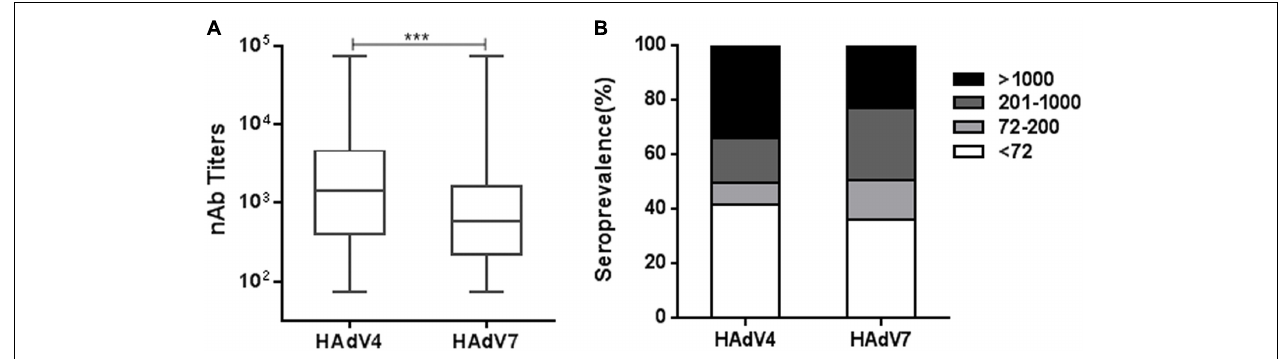
FIGURE 2 | The overall seroprevalence of anti-HAdV4 nAb and anti-HAdV7 nAb. (A) The nAb titers against HAdV4 and HAdV7 in seropositive individuals. The data was analyzed with the Mann-Whitney test. ∗∗∗ P < 0.001. (B) The distributions of anti-HAdV4 nAb and anti-HAdV7 nAb titers. nAb titers were classified into four subgroups: negative, < 72; low, 72–200; moderate, 201–1000; and high, > 1000. The percentages of individuals with negative, low, moderate, and high nAb titers were shown.